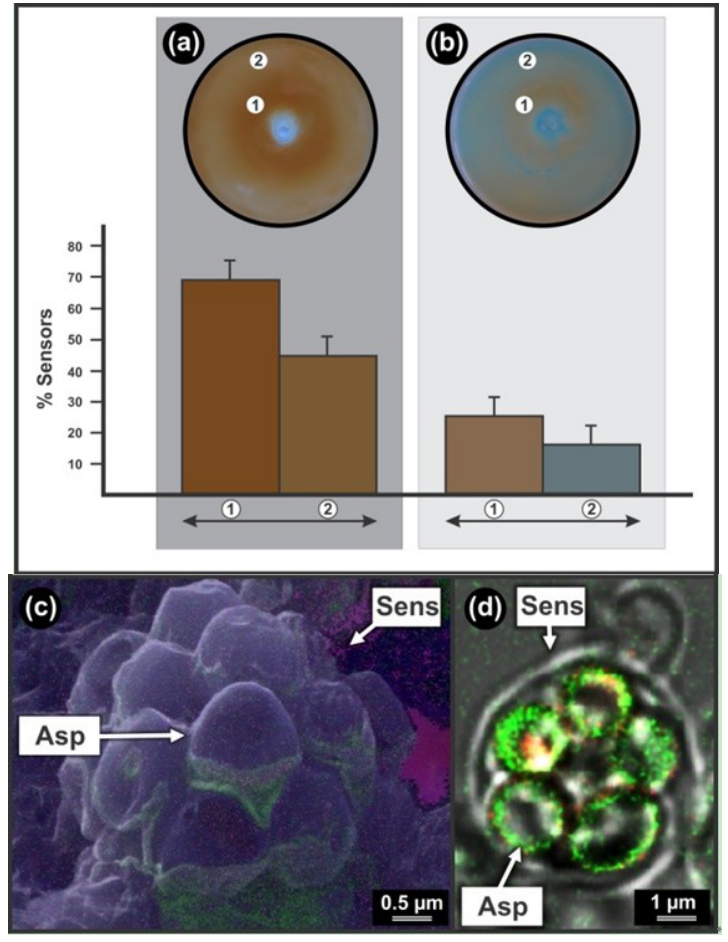
Figure 2. Colour sensors of Lipomyces yamadae sensing Chloroquine and the effect of preservation. ( a ) Bio-assay preparation without prior preservation of indicator yeast. Column 1 represents the percentage sensors relative to asexual cells counted in the darker brown zone (indicated as 1). Column 2 indicates the percentage sensors obtained in the lighter brown zone (indicated as 2). ( b ) Bio-assay preparation after one year of preservation. Column 1 indicates the percentage sensors relative to asexual cells counted in the darker brown zone (indicated as 1). Column 2 represents the percentage sensors in the lighter brown zone (indicated as 2). Values are the averages of a least three independent experiments and the bars indicate the standard deviation. ( c ) Sensor disassembly by Argon (Ar + ) etching visualized by Nano Scanning Auger Microscopy (NanoSAM). Green, gold; Blue, carbon; Pink, oxygen. ( d ) Increased fluorescence (green) surrounding ascospores inside sensor as observed by Confocal Laser Scanning Microscopy (CLSM). Parts of